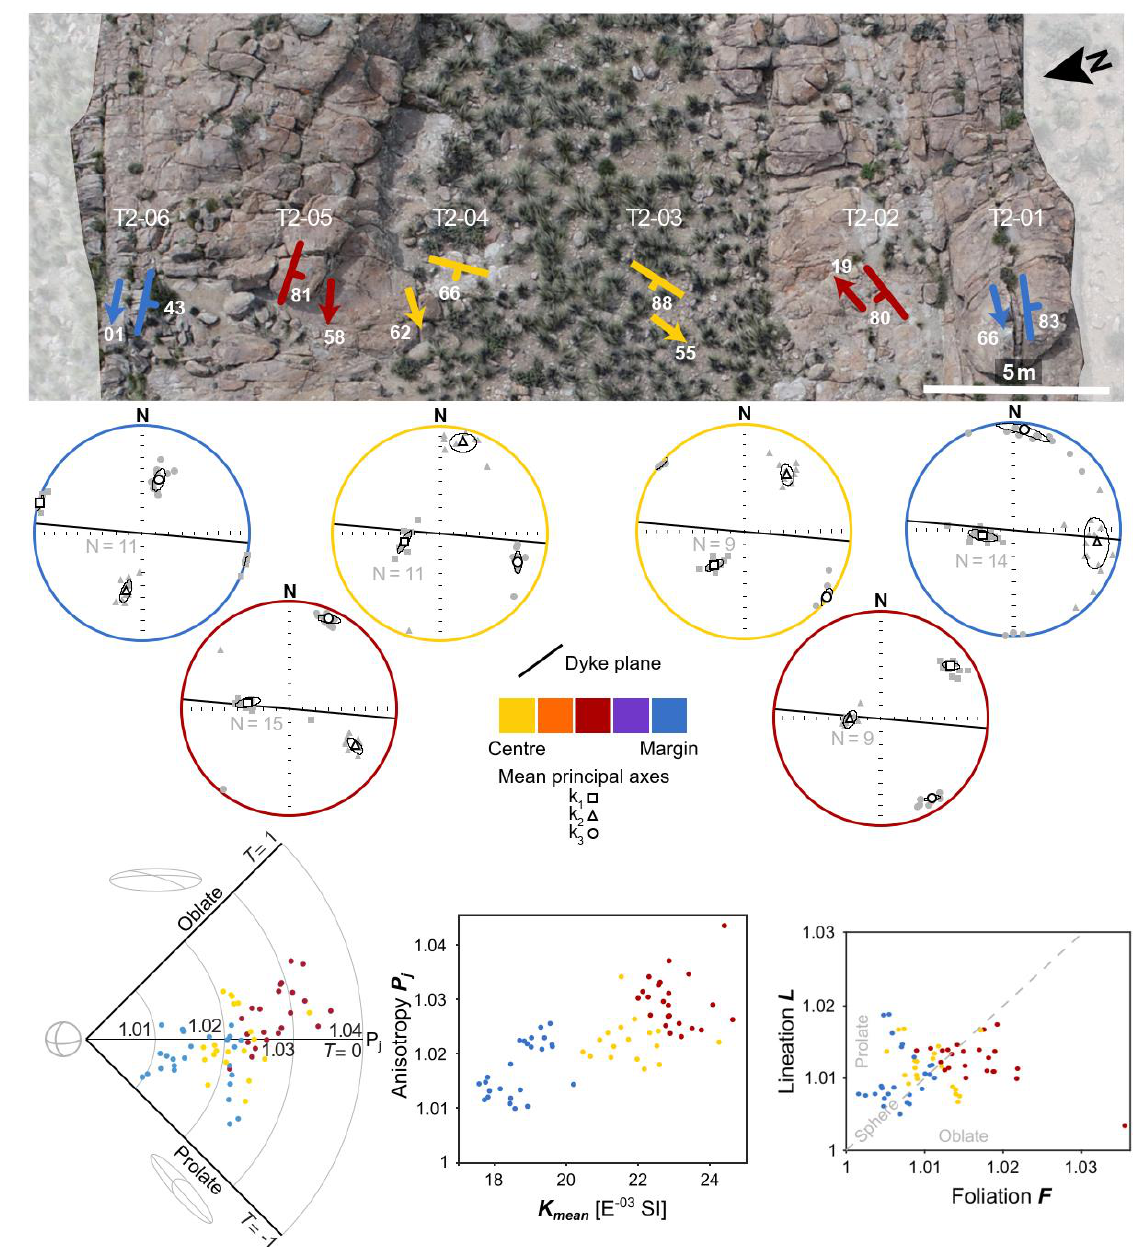
Figure 7. Sosa Dyke–Traverse T2 ipAMS. (Top row) Sample location of T2 (see Figure 2) The same sample locations were used for whole rock geochemistry samples (Table A1); Magnetic lineation (Arrows); Magnetic foliation (strike-dip symbols). (Middle row) ipAMS data; contour shows 95% Jelinek confidence ellipse of mean principal tensor. (Lower row) Shape parameter plots. The marginal samples display a dominantly margin-parallel transitional prolate fabric. Samples from the interior of the dyke exhibit triaxial to transitional oblate fabrics oriented obliquely to the dyke margin.